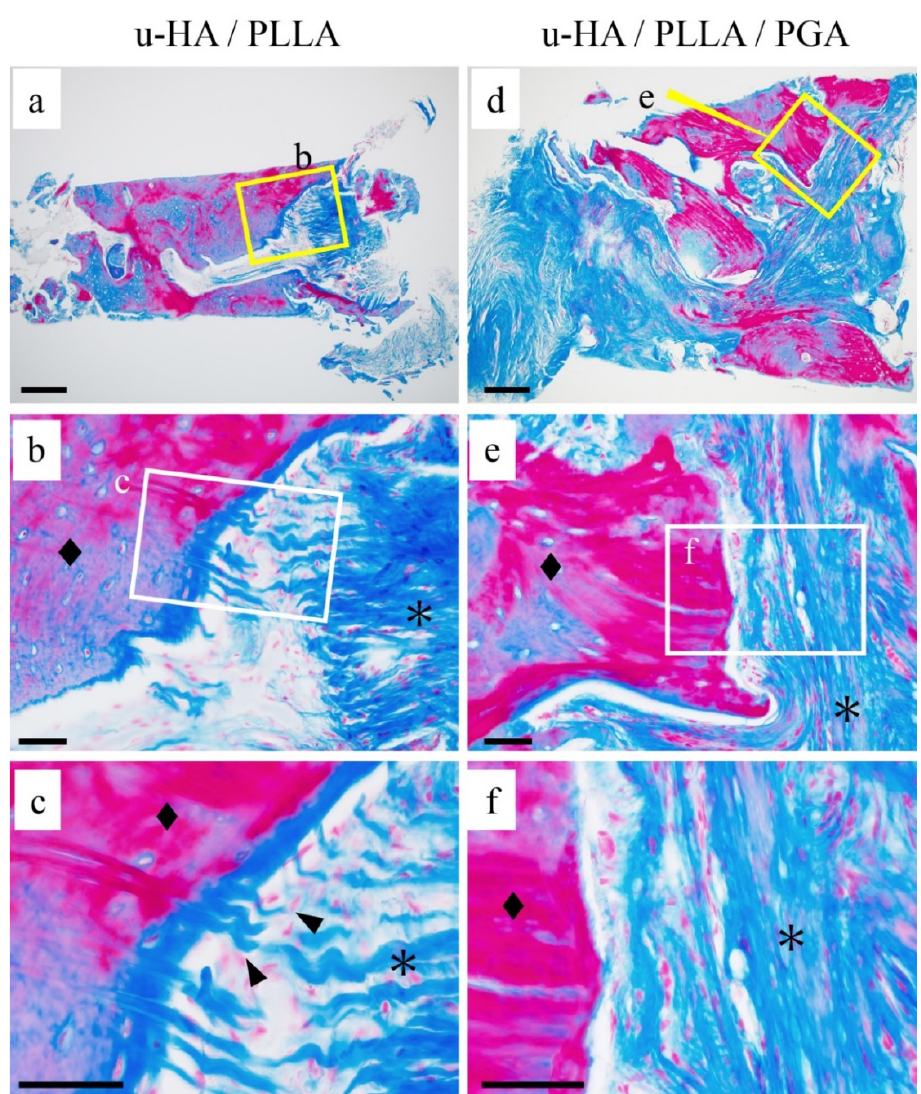
Figure 4. The differences in connective tissue findings. ( a – f ) Masson trichrome staining. ( a – c ) u-HA/ PLLA group: The fibers were present as bundles penetrating perpendicularly into the bone (c: ▲ ). ( d – f ) u-HA/ PLLA/PGA group: collagen fibers ran parallel to the bone. Bone ( (cid:7) ) and connective tissue (*). Bar: ( a , d ) 200 μm and ( b , c , e , f ) 50 μm.